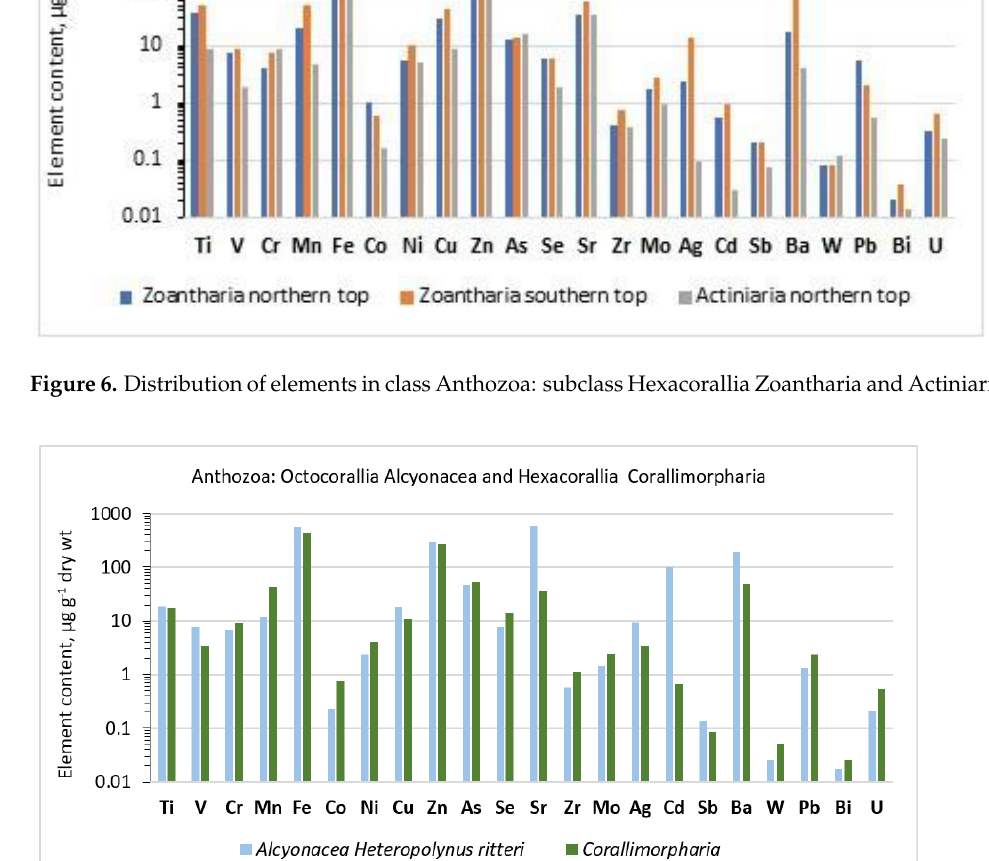
Figure 7. Distribution of elements in class Anthozoa: Heteropolynus ritteri (Octocorallia: Alcyonacea) and Corallinomorpharia (Hexacorallia).